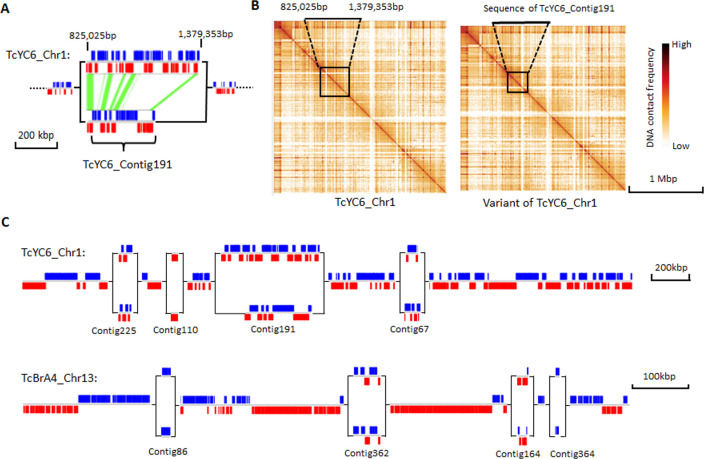
An example of homologous chromosomes with large allelic variations.(A) Synteny between two allelic variants in Chr1 of Y C6. Synteny blocks are marked with green. (B) Hi-C heat maps of TcYC6_Chr1 (left) and its homologous chromosome with TcYC6_Contig191 (boxed area) replacing the allelic region in TcYC6_Chr1 (boxed area). (C) Two chromosomes with multiple allelic variants. Blue blocks indicate genes on the forward strand, and red blocks indicate genes at the reverse strand.